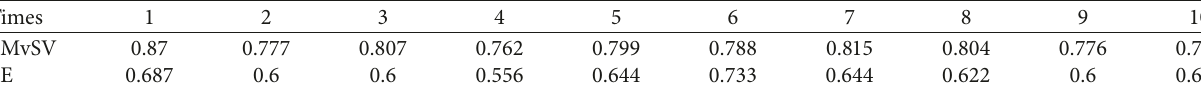
Table 9: Comparison of the correct rates of Algorithms FMvSV and FE in terms of AD200 with 2 . 5% missing values.